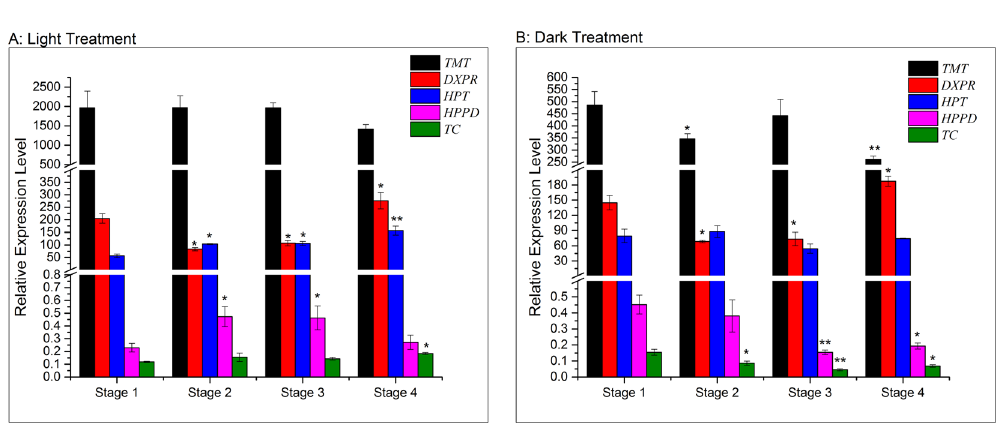
Figure 5. Changes of relative expression level of relevant genes in Vitamin E biosynthetic pathway during sweet corn seed germination; Bars with * and ** indicates significant difference at p < 0.05 and p < 0.01 respectively compared to stage 1. ( a ) Light treatment; ( b ) dark